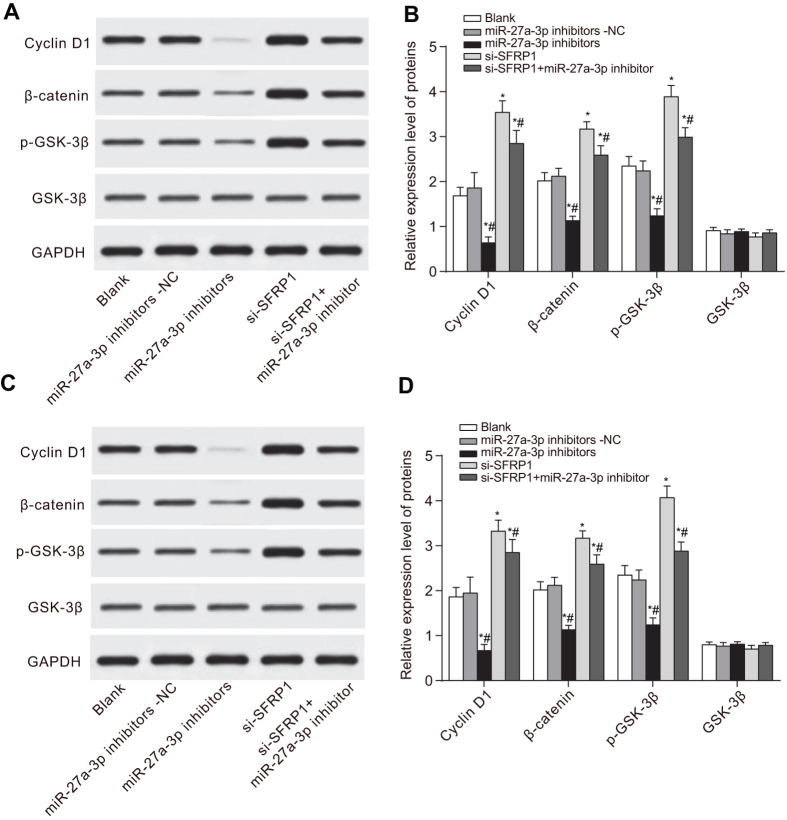
The expression of the proteins of the Wnt/β-catenin signaling pathway in OSCSCs in the miR-27a-3p inhibitors, miR-27a-3p inhibitors-NC, si-SFRP1, si-SFRP1 + miR-27a-3p inhibitors and blank groups as detected by Western blotting.(A,B) The expression of SFRP1, GSK-3P, p-GSK-3P, β-catenin and cyclin D1 in SCC-9 OSCSCs in the five groups. (C,D), The expression of SFRP1, GSK-3P, p-GSK-3P, β-catenin and cyclin D1 in Tca8113 OSCSCs in the five groups. *Represents P < 0.05 comparisons with the blank and miR-27a-3p inhibitors-NC groups. #Represents P < 0.05 comparisons with the si-SFRP1 group. OSCSCs, oral squamous carcinoma stem cells.